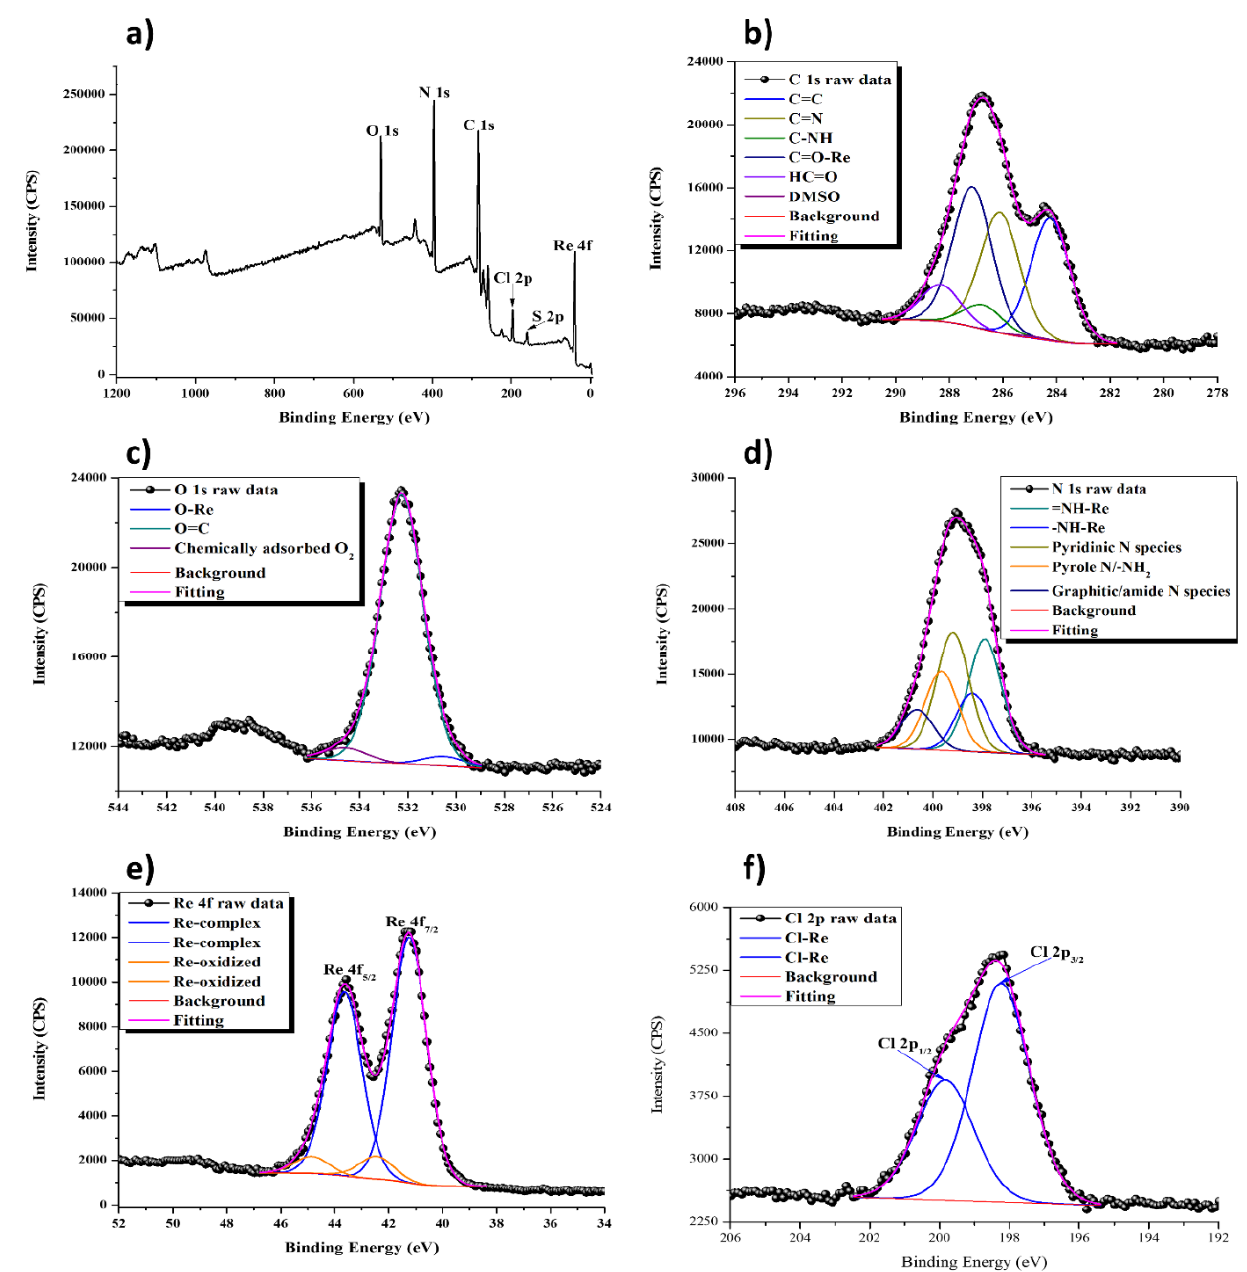
Figure 5. XPS spectra of the Re@POP1 sample, ( a ) wide scan; ( b ) C 1s high resolution spectrum; ( c ) O 1s high resolution spectrum; ( d ) N 1s high resolution spectrum; ( e ) Re 4f high resolution spectrum; ( f ) Cl 2p high resolution spectrum.